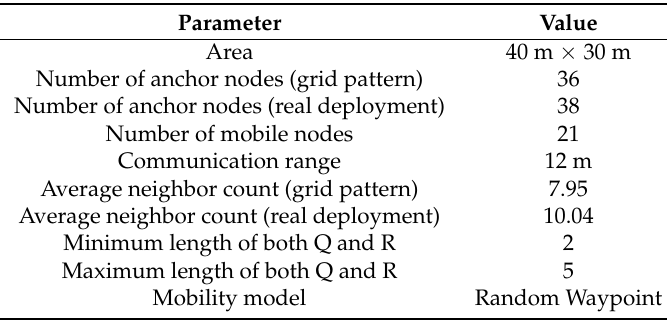
Table 1. Summary of simulation